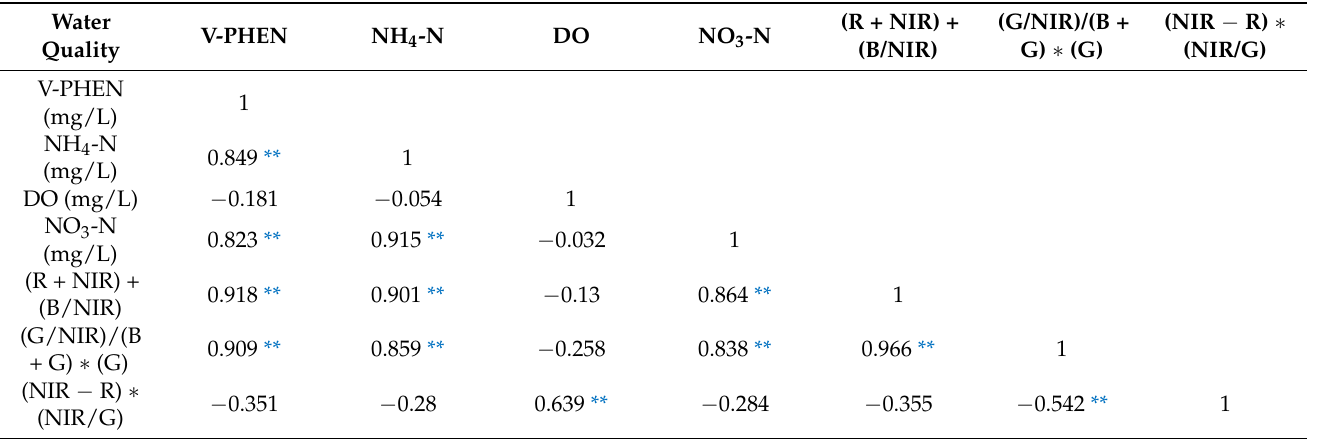
Table 2. Correlation matrix for in situ data and surface reflectance of visible and near-infrared of Landsat TM5, ETM+7, and OLI8